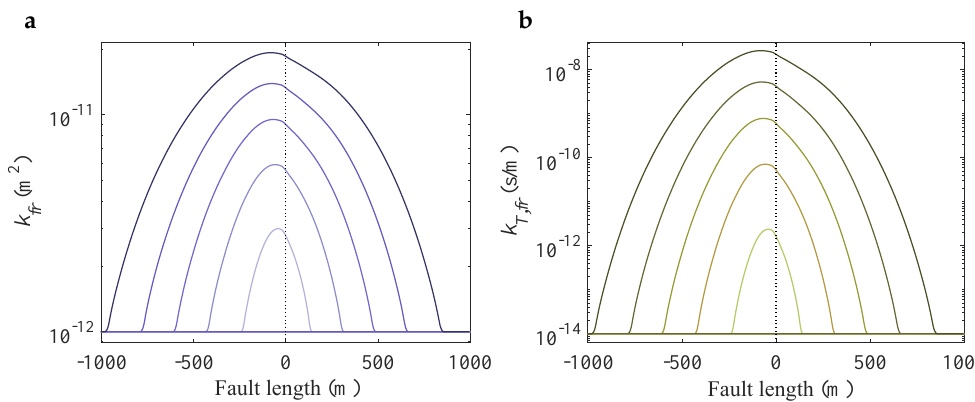
Figure 5. Changes in permeability on the fault zone at several time steps during the rupture. In panel ( a ), we show the fault permeability k fr for several time steps. In panel ( b ), we plot the value of the coefficient k T , fr that controls the transversal flow on the